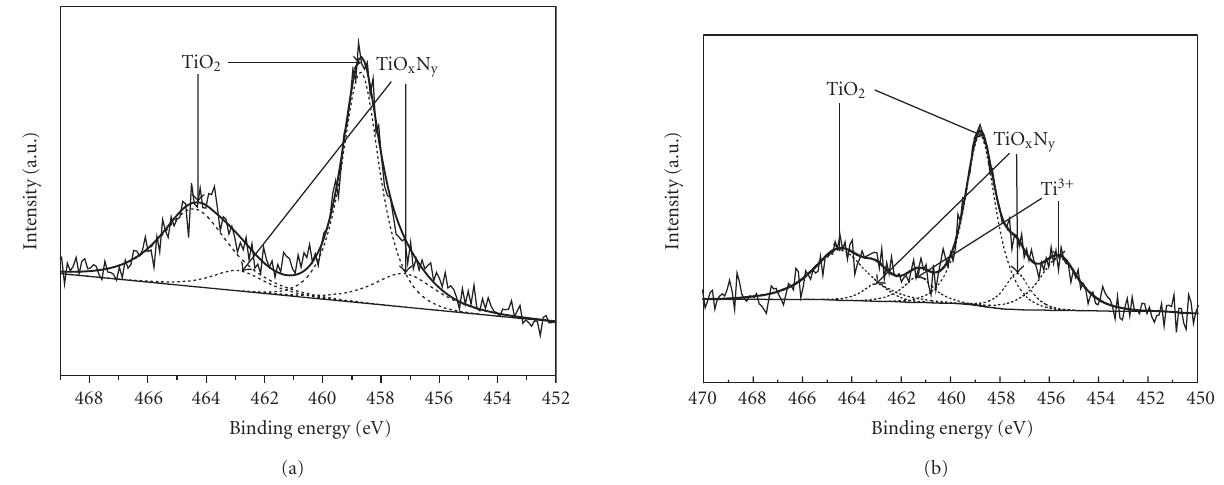
Figure 6: (a) Ti 2p core-level spectrum (deconvolution of Ti 2p bands) of TDN. (b) Ti 2p core-level spectrum (deconvolution of Ti 2p bands) of TNB.